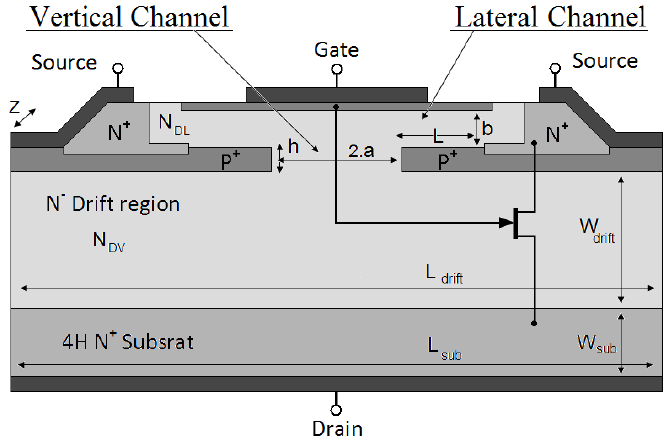
Figure 1. Cross-sectional view of the two channel SiC-JFET